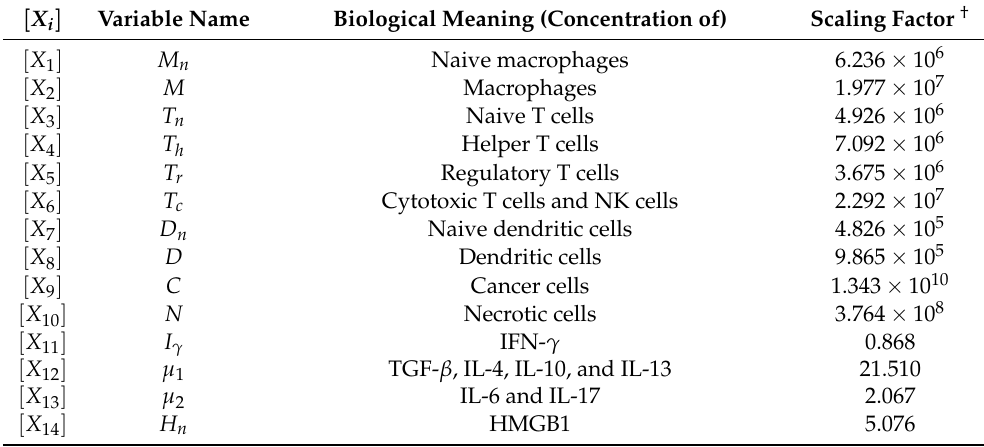
Table 1. Variable names corresponding to [ X i ]